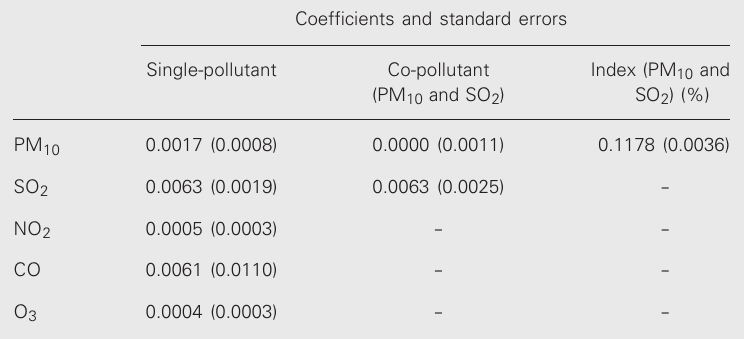
Table 3. Estimated regression coefficients and standard errors for concurrent day pollutant concentrations using single-pollutant and co-pollutant models, and the index combining PM 10 and SO 2 , controlling for seasonal trends, holidays, and weather